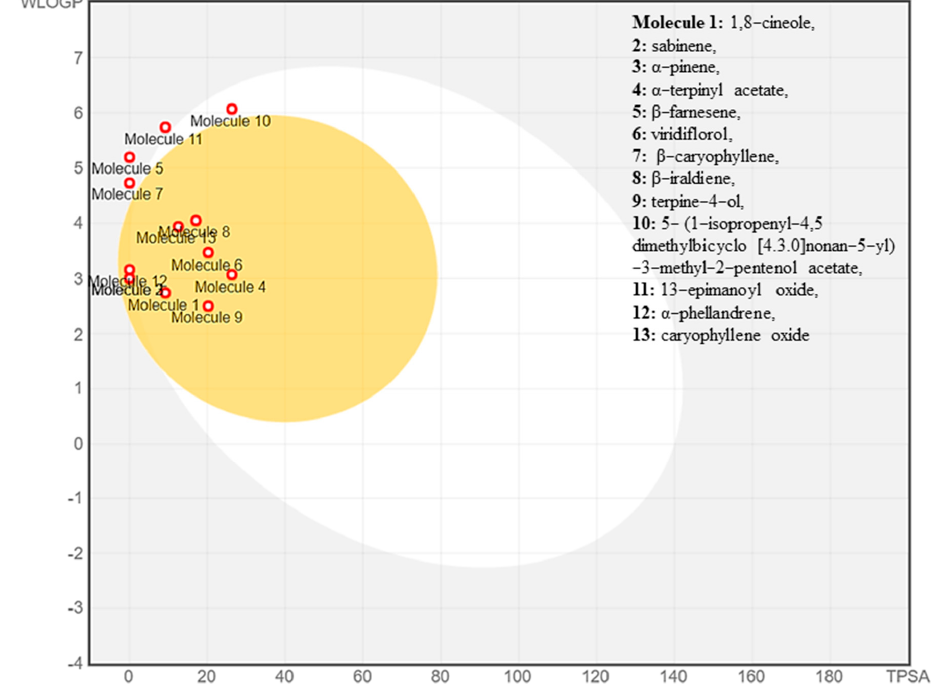
Figure 8. Boiled-egg graph of the selected phytoconstituents.